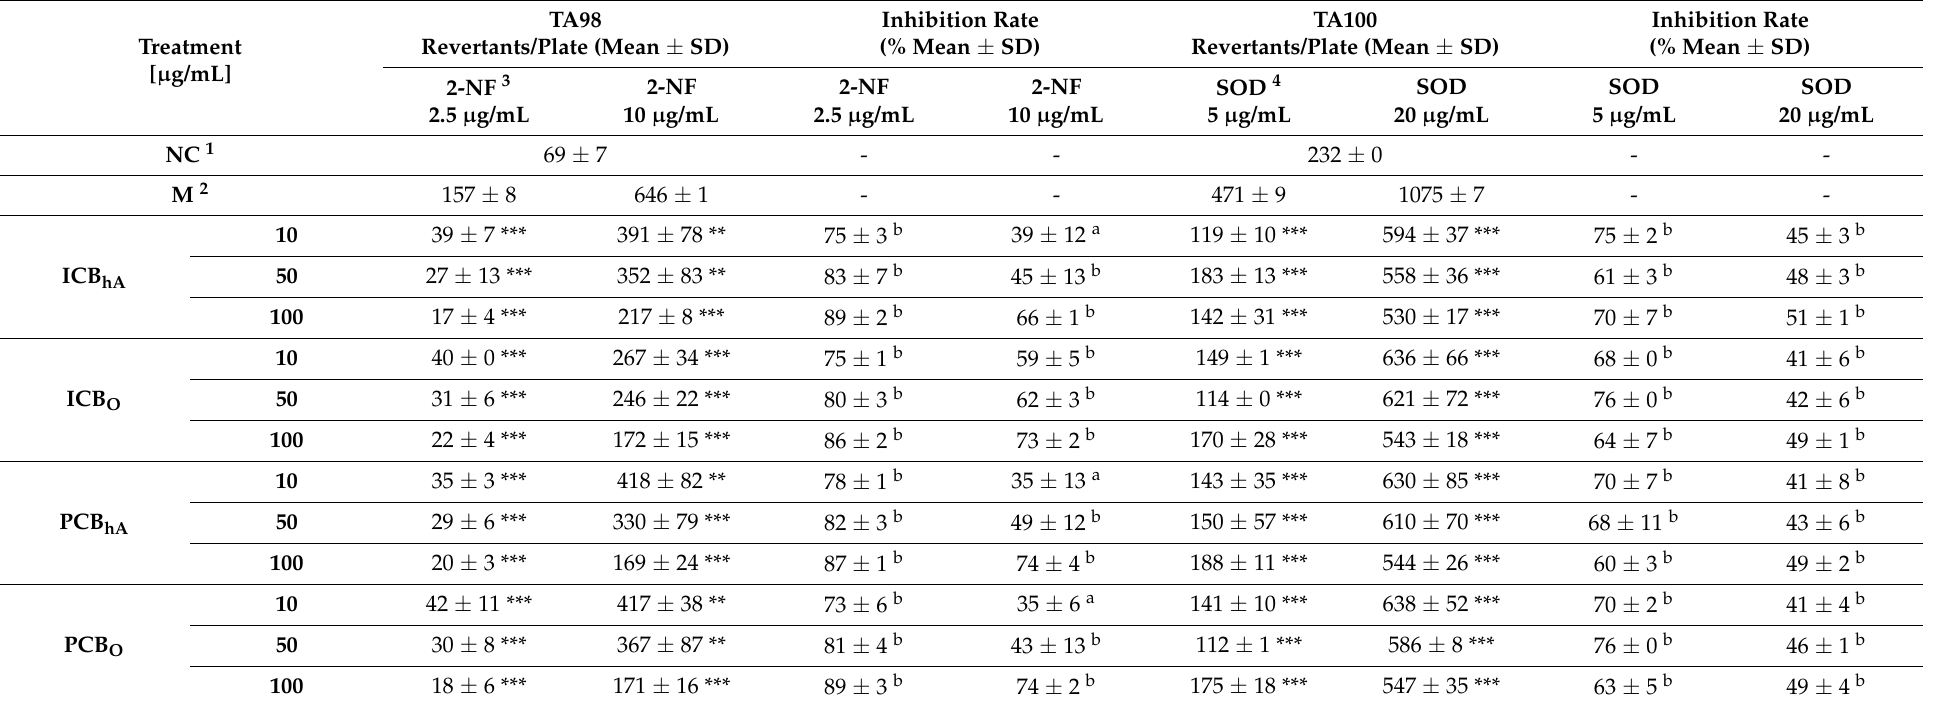
Table 2. Antimutagenic activity. Antimutagenic activity of hydroalcoholic and chloroform extracts of ICB and PCB samples (10, 50, 100 µ g/mL) in TA98 and TA100 strains after co-incubation with standard mutagens, respectively 2-nitrofluoren (2-NF, 2.5 and 10 µ g/mL) and sodium azide (SOD, 5 and 20 µ g/mL). Results (coming from three independent experiments) are expressed as mean of revertants/plates ± SD and as mean of inhibition rates % ± SD. Significant difference for ** p < 0.01 and *** p < 0.001 ( Dunnett’s test ) was calculated comparing extracts co-treated with standard mutagens to single standard